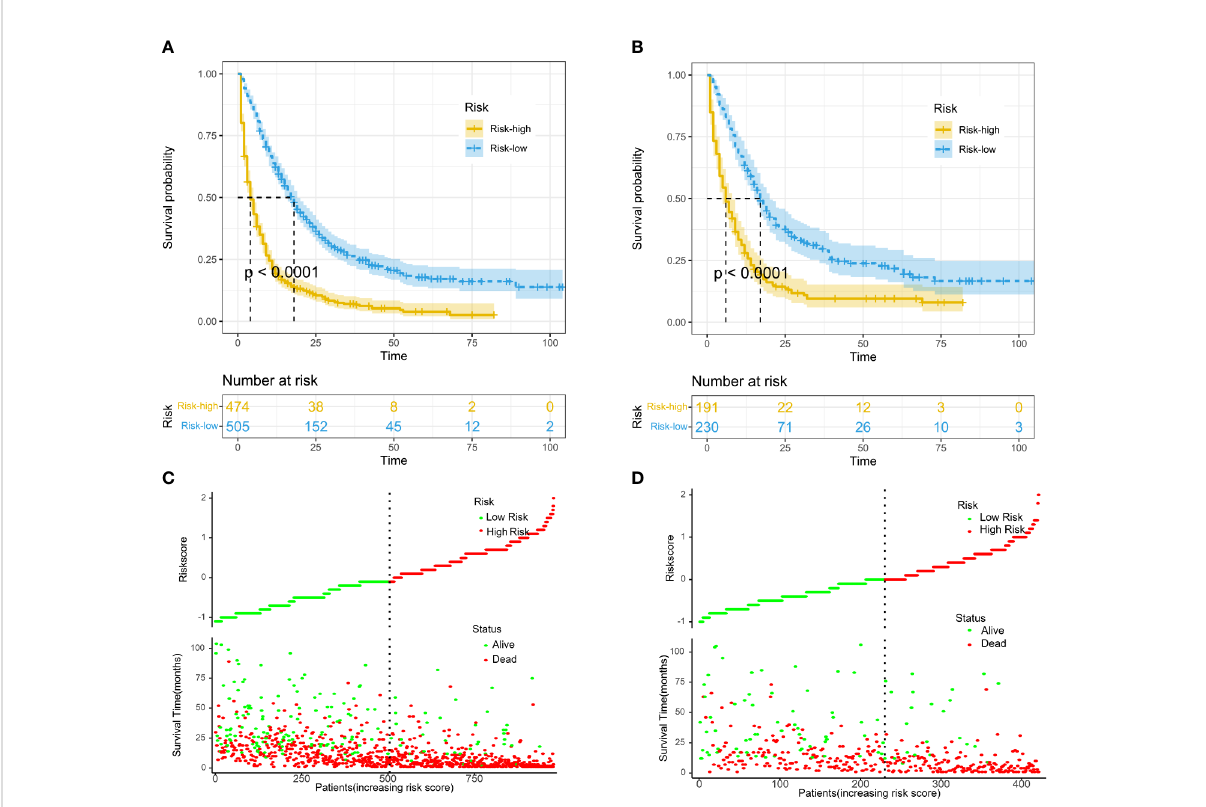
FIGURE 3 Kaplan – Meier curves of overall survival (OS) for risk strati fi cation in the training cohort (A) and validation cohort (B) . Scatter diagram displaying the survival status, survival time, and risk score for risk strati fi cation in the training cohort (C) and validation cohort (D)